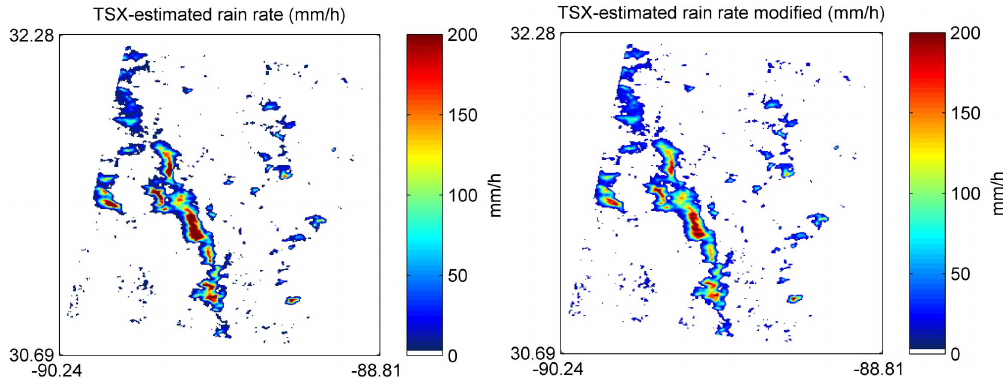
Fig. 5. Left: TSX-estimated rain rate according to the regressive empirical algorithm (REA) approach of Eq. (3), as suggested in Marzano et al. (2010), using TSX data of Fig. 4. Right: TSX-estimated rain rate according to the modified regressive empirical algorithm (MREA), given in Eq. (4). For graphical purposes scales are equally saturated at 200mmh − 1 , even though rain-rate values can be higher than 300mmh − 1 (see